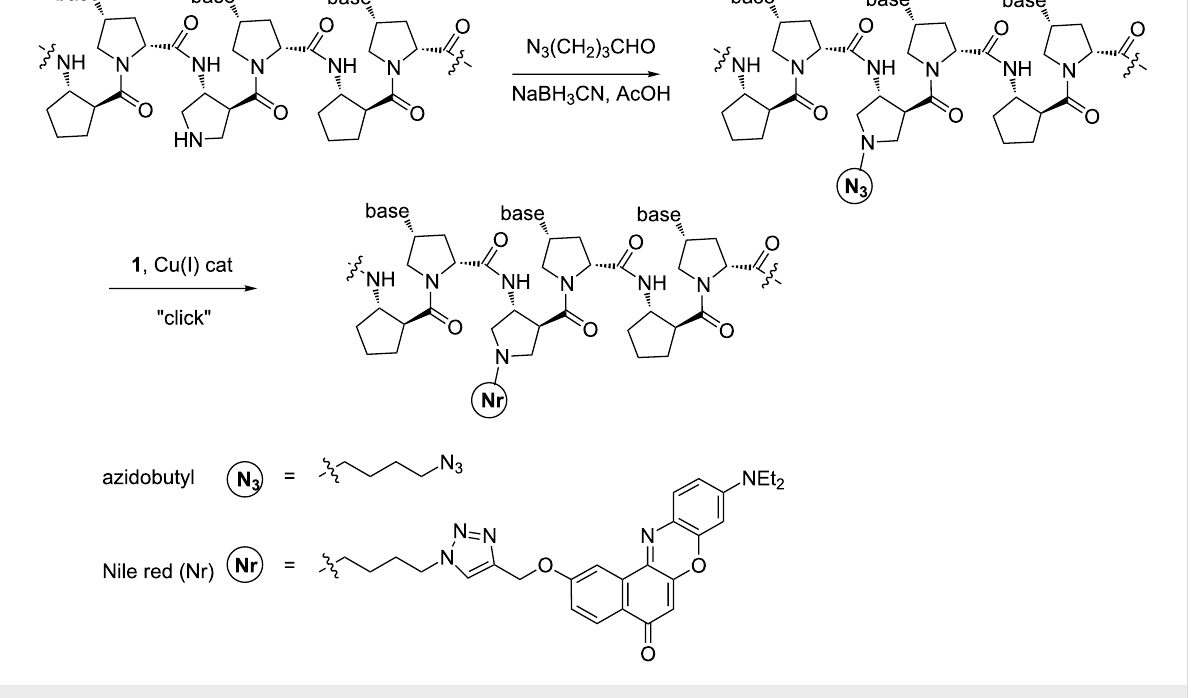
Scheme 2: Synthesis of azidobutyl- and Nile red-modified acpcPNA.